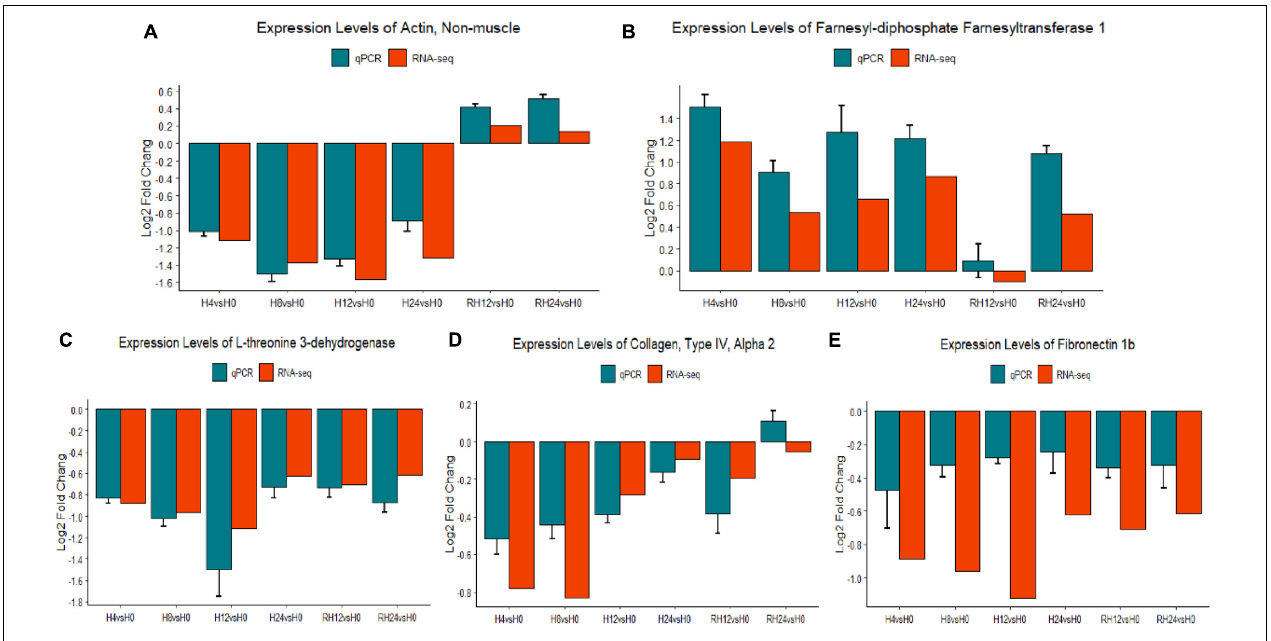
FIGURE 5 | Comparison of gene expression data between RNA-seq and quantitative real-time PCR (qRT-PCR). The expression level of actin, non-muscle (A) , farnesyl-diphosphate farnesyltransferase 1 (B) , L-threonine 3-dehydrogenase (C) , collagen type IV alpha 2 (D) , and fibronectin 1b (E) in different